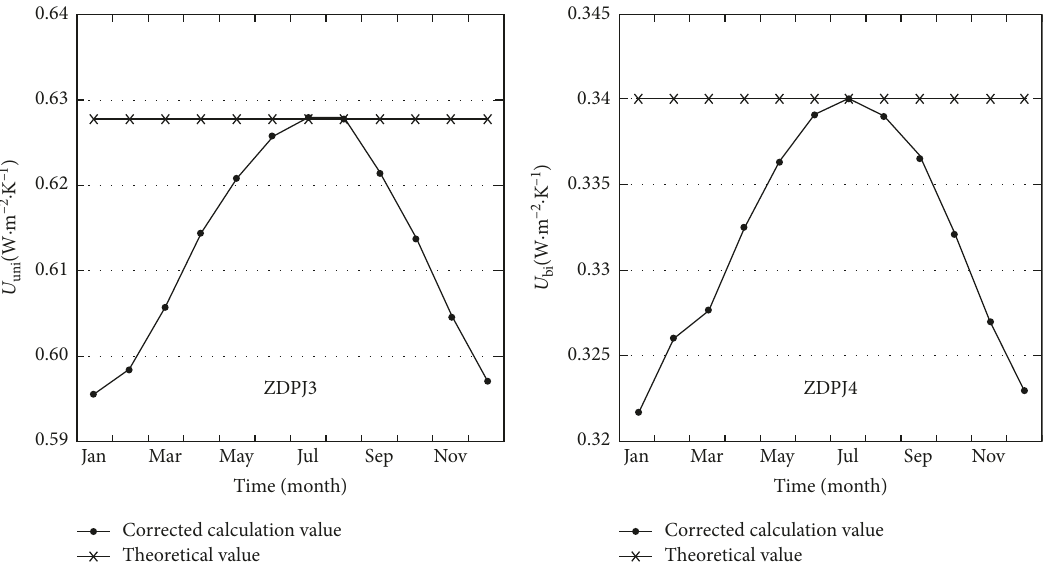
Figure 5: Comparing corrected computational method of monthly mean heat transfer coefficients ( U ) and theoretical values of ZDPJ3 and